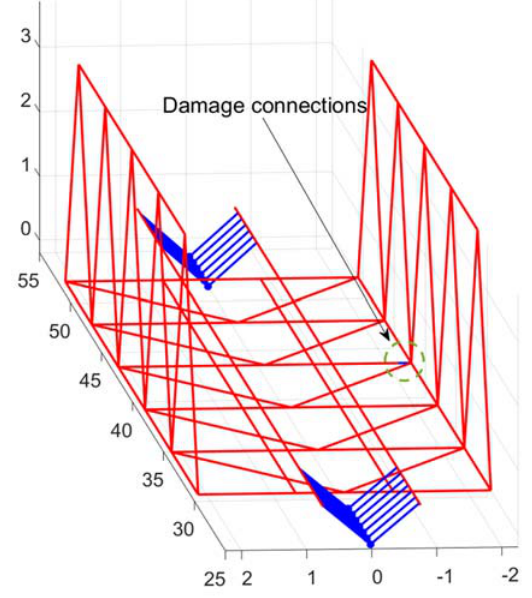
Figure 3. Damage affecting the connection between the cross-girder and lower-chord (green dashed circle). The blue points represent sleepers masses. The blue lines outside the bridge, identify rail pad connections, modelled by means of springs.